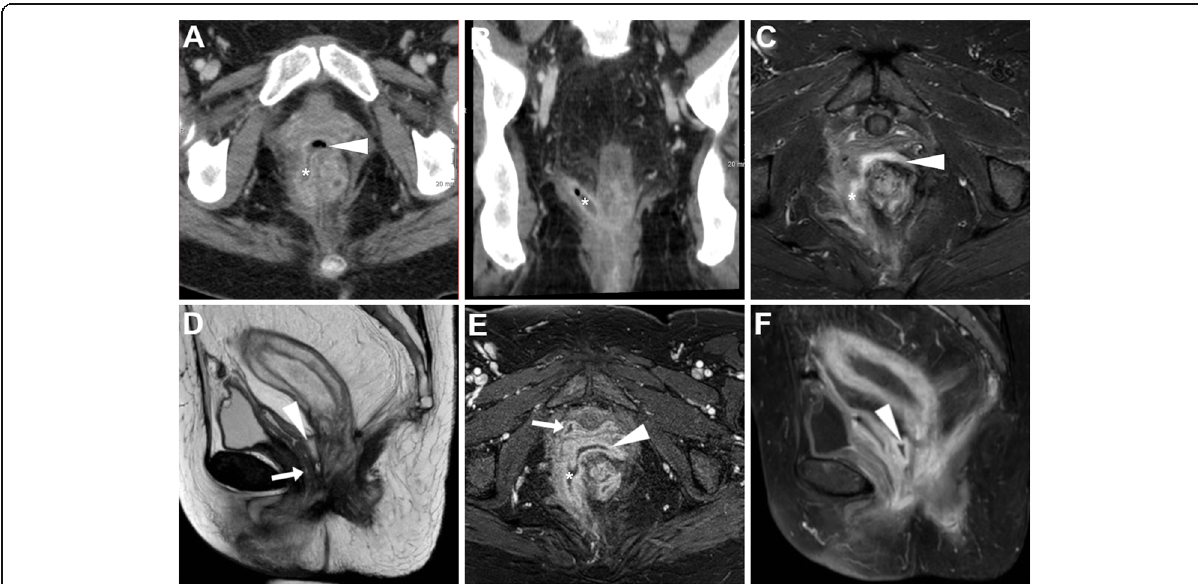
Fig. 13 MRI-like use of CT to investigate CD-related perianal inflammatory disease. In a 50-year-old, small-FOV axial ( a ) and oblique-coronal ( b ) CT reformatted images show peripherally enhancing abscess collection extending from the anovaginal septum (arrowheads) to the right levator ani muscle (*). Axial FS ( c ) and sagittal ( d ) T2-weighted, post-gadolinium FS axial ( e ) and sagittal ( f ) T1-weighted MRI images show same findings with fluid-filled abscess cavities with strong mural enhancement. Note severe proctitis as circumferential thickening of rectal walls with oedematous submucosa (in d ) and marked homogeneous enhancement (in f )